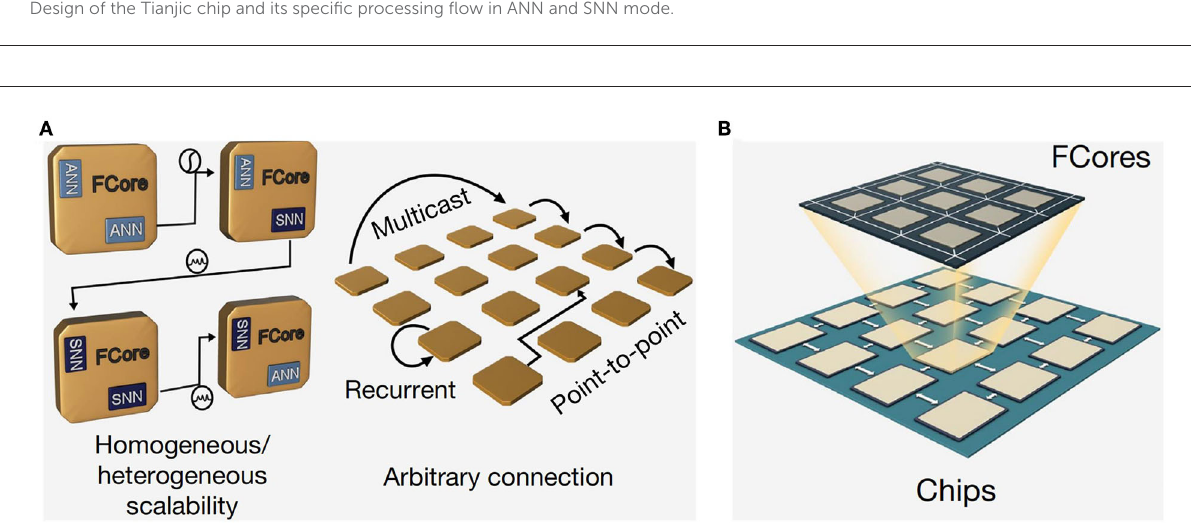
FIGURE6 Arrangement format of Fcores on the Tianjic chip. (A) Reconfigurable routing tables of the routers of FCore have the ability of arbitrary connection topologies. (B) The arrangement of Fcore on the